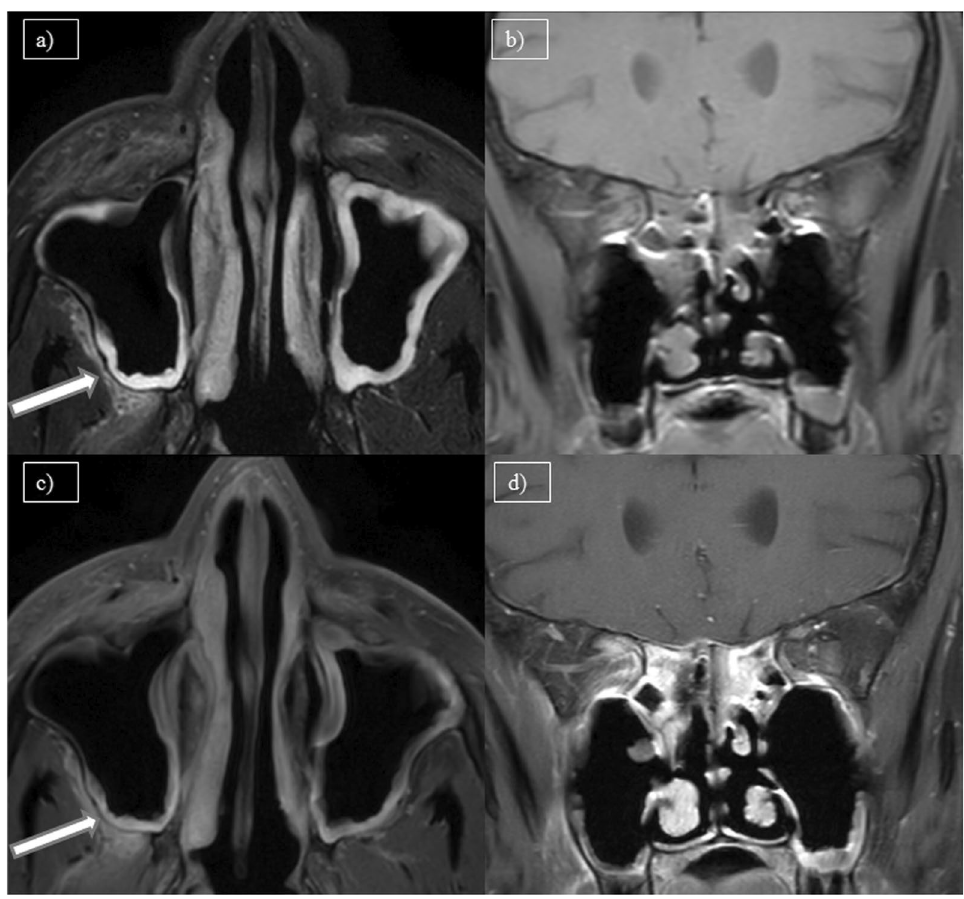
Fig. 2 a MRI Axial T2W-FS, b coronal pre-contrast T1W-FS, c and d axial and coronal post-contrast T1W-FS images of a 52-year-old female patient with complaints of headache and rhinorrhea showing bilateral maxillary sinusitis with T2 hyperintense periantral space fat stranding which is showing significant post-contrast enhancement